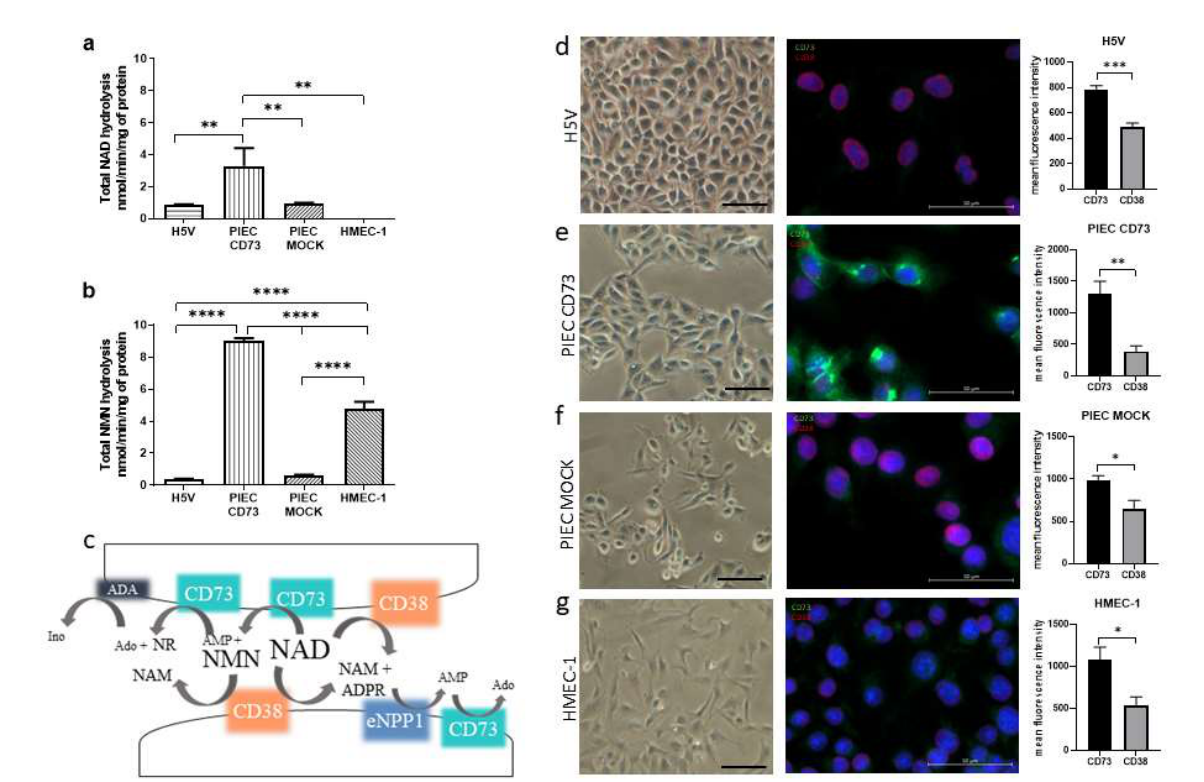
Figure 1. Nicotinamide adenine dinucleotide (NAD + ) and nicotinamide mononucleotide (NMN) hydrolysis are different for various endothelial cell types. Comparison of total NAD + ( a ) and NMN ( b ) hydrolysis on endothelial cell lines. Results are presented as the mean ± SEM; n = 3–6; ** p < 0.01 **** p < 0.0001 with one-way ANOVA followed by Tukey’s multiple comparisons test. Diagram of NAD + and NMN metabolism in the extracellular space ( c ). Immunofluorescence staining and quantification for CD73 (green signal) and CD38 (red signal) on cell lines. Cell nuclei were counterstained with DAPI (blue signal) for H5V ( d ), PIEC CD73 ( e ), PIEC MOCK ( f ), and HMEC-1 ( g ). Results are presented as the mean ± SEM; n = 5; * p < 0.05, ** p < 0.01, *** p < 0.001 by student unpaired t -test.